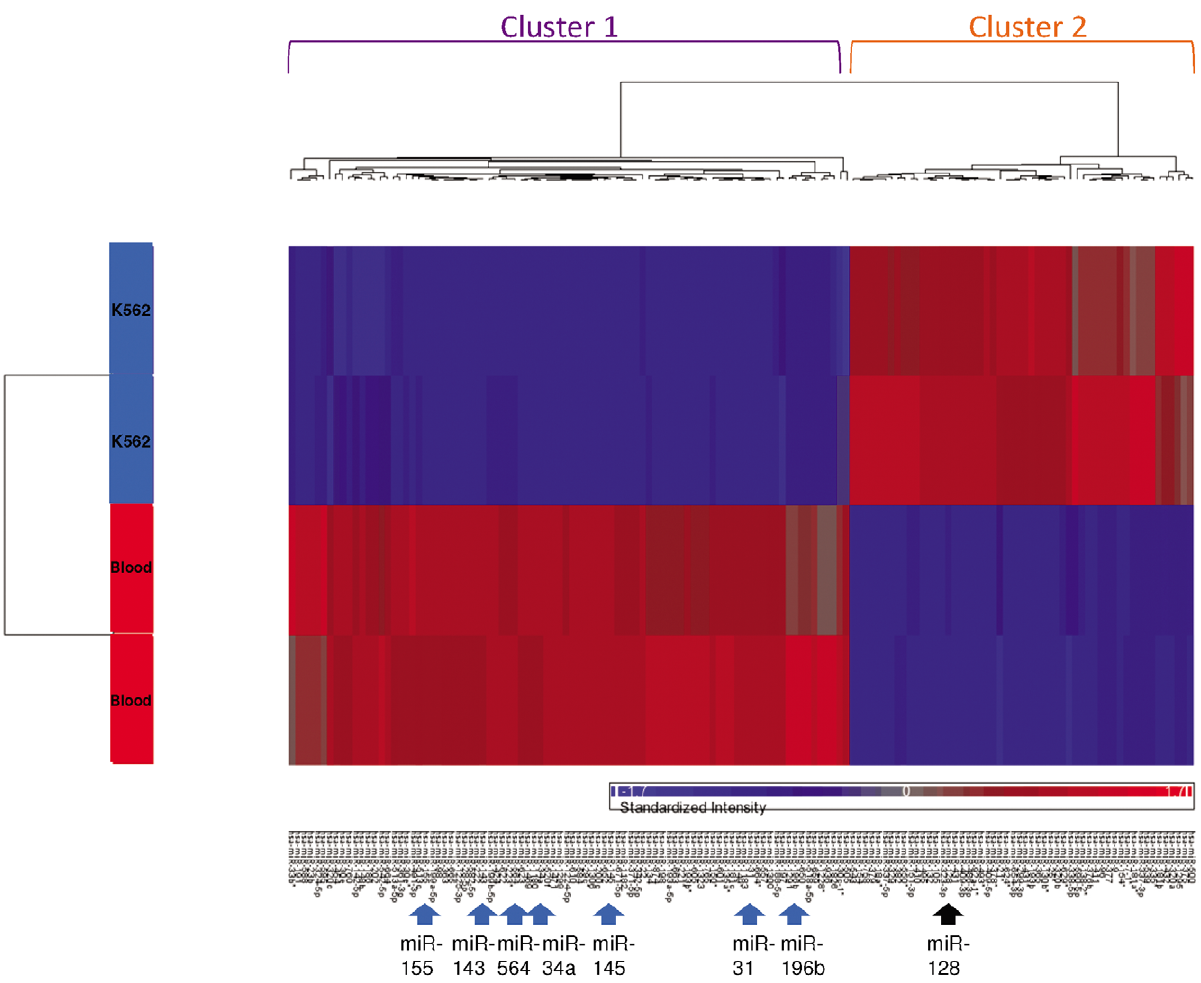
Figure 1. Unsupervised clustering analysis of miRNA expression in K562 cells as compared to a pooled sample of healthy blood. Heat maps illustrating unsupervised clustering of miRNAs that were differentially expressed between blood and K562 samples. The red and blue colors indicate relatively high and low fold-change of expression, respectively. Missing values are indicated in gray. The 8 miRNAs we focused on are indicated with arrows at the bottom of the cluster. Blue arrows represent miRNAs whose expression was downregulated in K562 vs blood, the black arrow represent miRNA whose expression was upregulated in K562 vs blood. Two main miRNAs clusters are shown on top (cluster 1; purple and cluster 2, orange), correlated with the expression patterns described above.